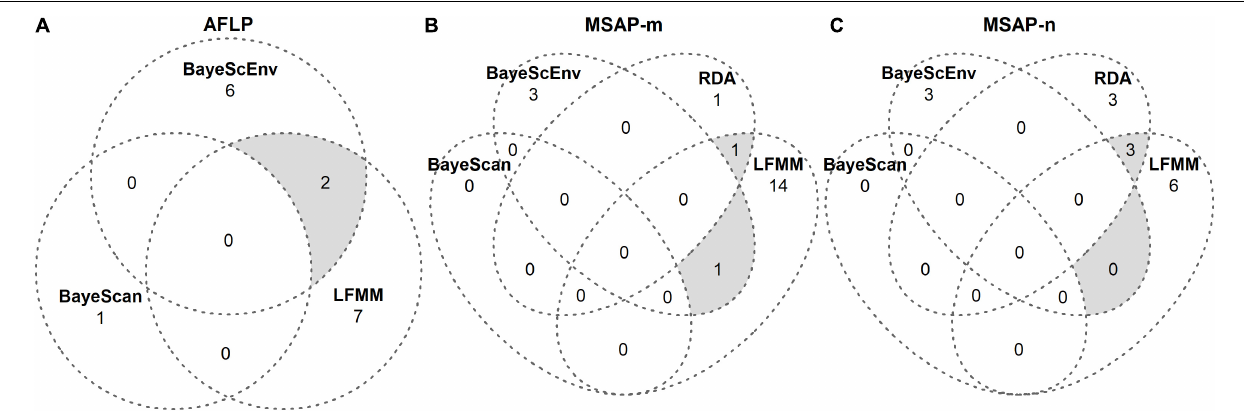
FIGURE 3 | Venn diagrams from genome scans for outlier loci in S. canadensis . Outlier loci were detected using the genome-scan approaches B AYE S CAN , B AYE S C E NV , LFMM, and RDA separately on (A) genetic (AFLP) and (B,C) epigenetic (MSAP-m, MSAP-n) datasets. Details of these approaches are given